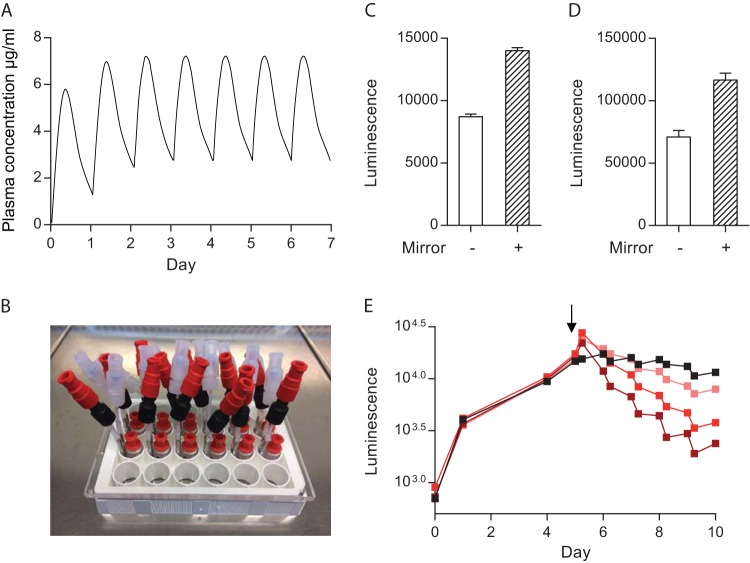
Modeling of antibiotic pharmacokinetics by integrating microspheres with a microfluidic system. (A) Representation of antibiotic pharmacokinetics in human plasma after daily oral administration during treatment. (B) Microfluidic system with two input channels and one exit channel for a 24-well tissue culture plate. (C, D) Placement of a basal mirror doubles the detection of M. tuberculosis luminescence by the GloMax Discover plate reader. Luminescence from infected PBMCs in microspheres in a single well in the absence (no fill) or presence (stripes) of a basal mirror for 24-well (C) and 96-well (D) tissue culture plates. (E) Modeling of antibiotic concentration profiles with a microfluidic system. From day 5 (black arrow), various peak concentrations of antibiotics were introduced for 6 h via the fluidic system and then washed out to approximate pharmacokinetics in vivo. Increasing rifampin concentrations (0.25 µg/ml [salmon], 1 µg/ml [bright red], and 4 µg/ml [dark red]) progressively accelerated M. tuberculosis killing. The black line represents a control sample to which the carrier DMSO was added and identical washes were performed. Three independent experiments were carried out, and the results of a representative experiment are shown.